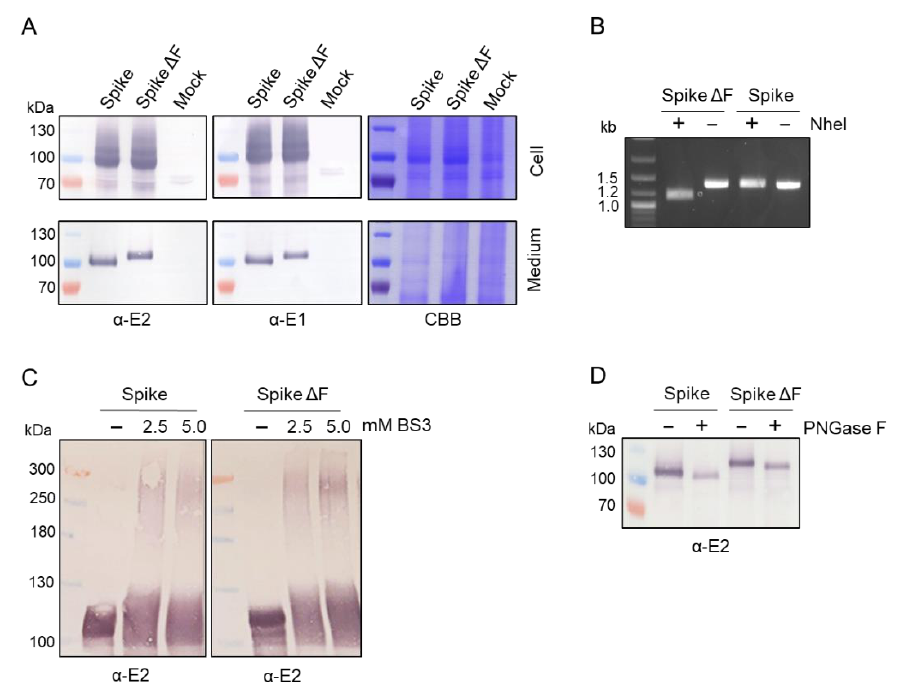
Figure 2. Secreted, glycosylated trimeric CHIKV spikes with and without furin cleavage site ( ∆ F). Adherent Sf21 cells were uninfected (mock) or infected with Ac-Spike or Ac-Spike ∆ F. ( A ) Recombinant baculovirus expressed proteins in the cell and medium fraction were analyzed by Coomassie Brilliant Blue (CBB) staining and Western blotting using CHIKV E1 and E2 antibodies (α-E2 and α-E1). ( B ) The furin cleavage site mutation in the recombinant baculovirus DNA was verified by NheI restriction enzyme digestion of CHIKV E3E2 PCR fragments loaded on agarose gel. ( C ) The oligomeric configuration of the secreted CHIKV proteins was analyzed by α-E2 Western blotting after 2.5 and 5.0 mM BS3 cross-linking, and ( D ) the glycosylation status by α-E2 Western blotting after PNGase F treatment.